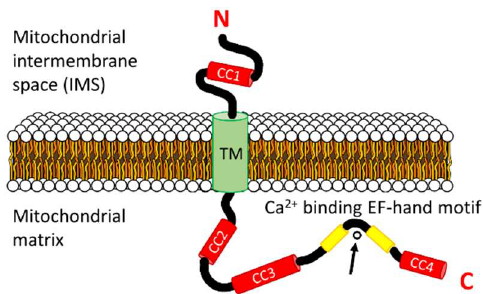
Figure 2. Prevailing topology of the full length human LETM1 monomer. The topology is shown with respect to the inner-mitochondrial membrane (IMM) showing the N-terminal region within the mitochondrial inter-membrane space (IMS) and the C-terminal region within the mitochondrial matrix. The locations of the coiled-coils (CCn; red) relative to the transmembrane domain (TM; green), the EF-hand motif (yellow) and the IMS and matrix compartments are shown. The Ca 2+ cation coordinated by the EF-hand loop is indicated by the arrow. The amino and carboxyl termini are denoted by N and C, respectively.